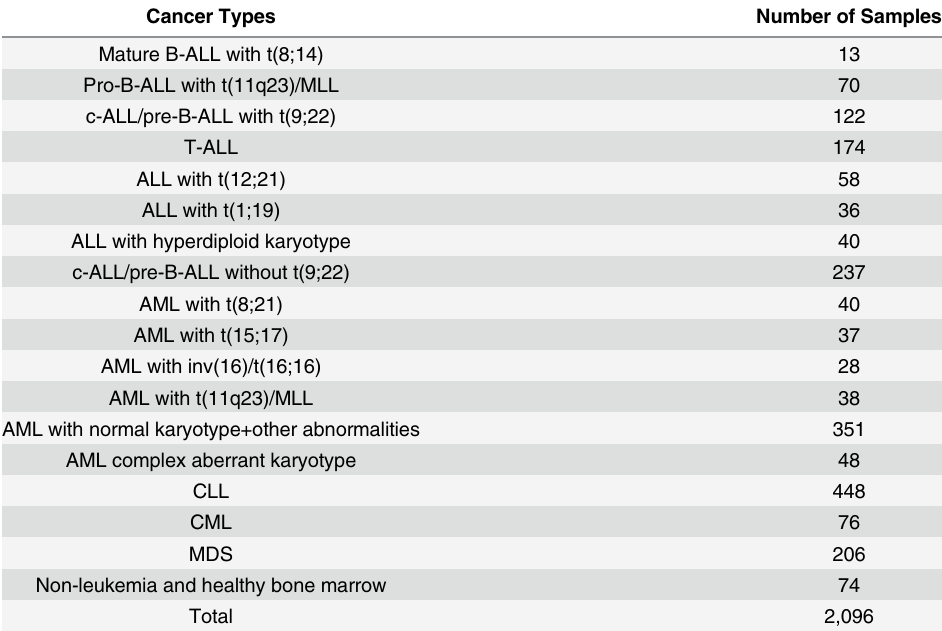
Abbreviations: B-ALL, B-cell acute lymphoblastic leukemia; MLL, myeloid/lymphoid or mixed-lineage leukemia; pre, precursor; c-ALL, childhood acute lymphoblastic leukemia; T-ALL, T-cell acute lymphoblastic leukemia; ALL, acute lymphoblastic leukemia; AML, acute myeloid leukemia; CLL, chronic lymphocytic leukemia; CML, chronic myelogenous leukemia; MDS, myelodysplastic